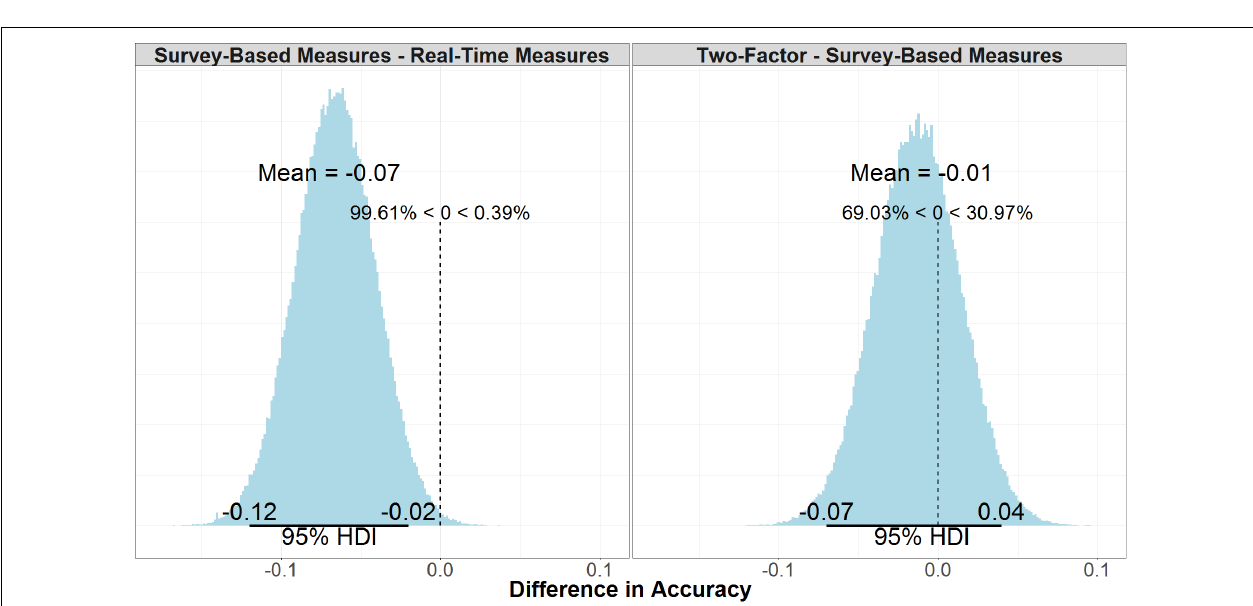
FIGURE 10 | Difference in the expected log predictive density of the real-time measures model and the survey-based model and the survey-based measures model and the two-factor model.